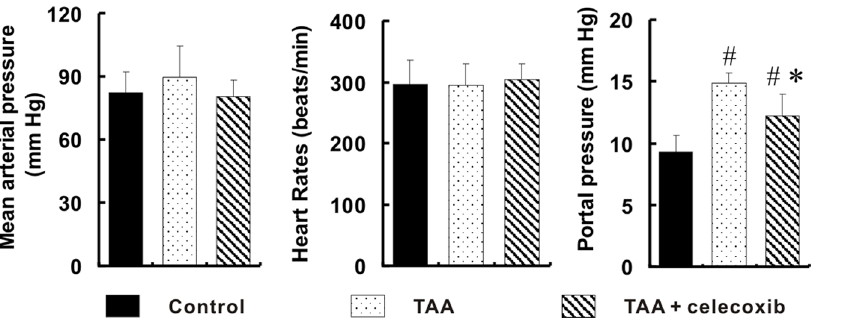
Figure 5. Decrease of portal hypertension by celecoxib treatment. There were no significant differences of the mean arterial pressure and heart rate among three groups, p . 0.05. The portal pressure measured by introduced catheters in TAA group was the highest among three groups. # p , 0.01 vs . control group; * p , 0.01 vs . TAA group.